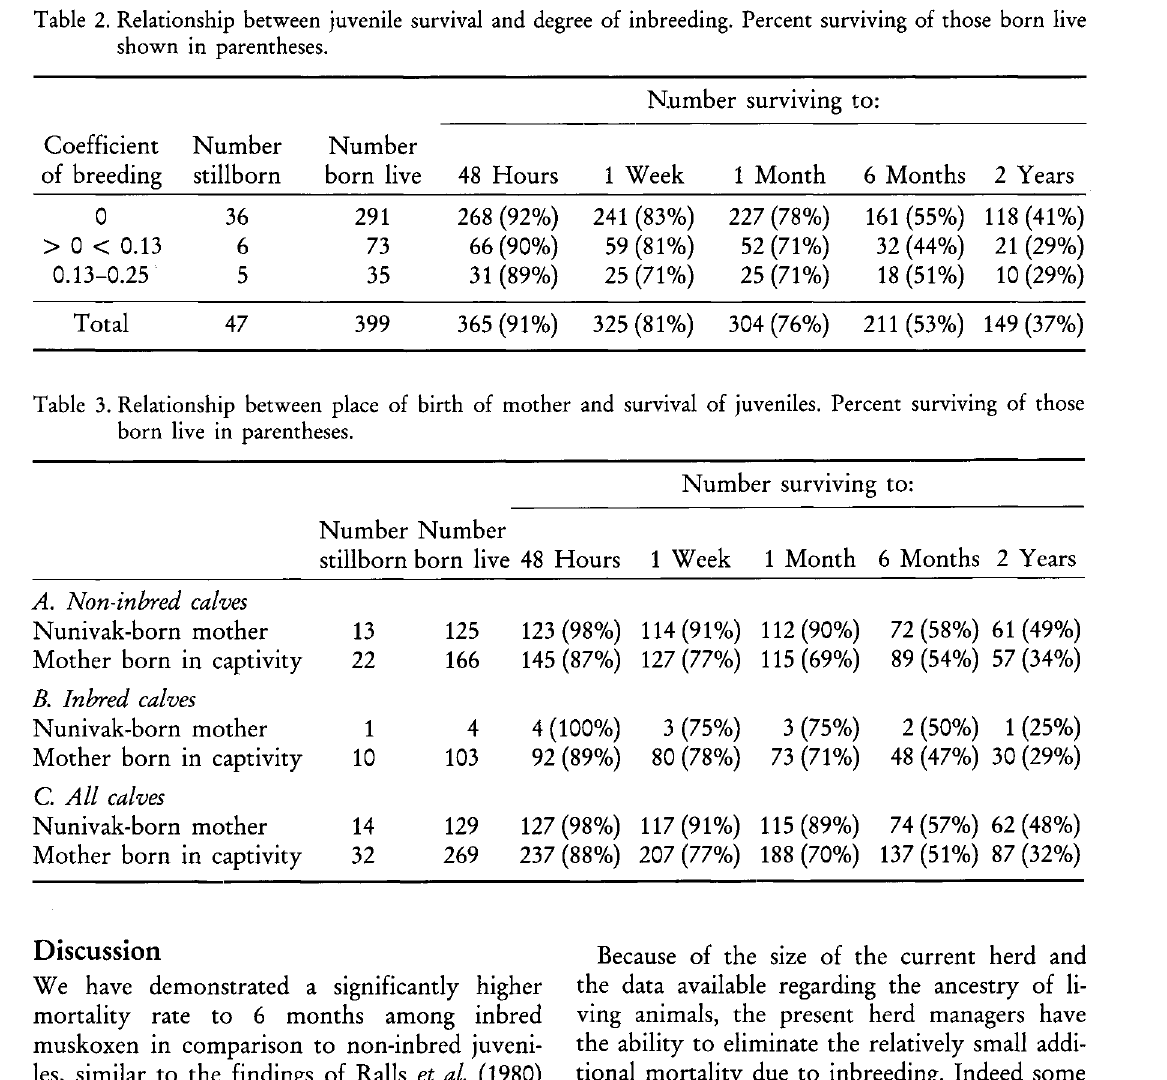
Table 3. Relationship between place of birth of mother and survival of juveniles. Percent surviving of those born live in